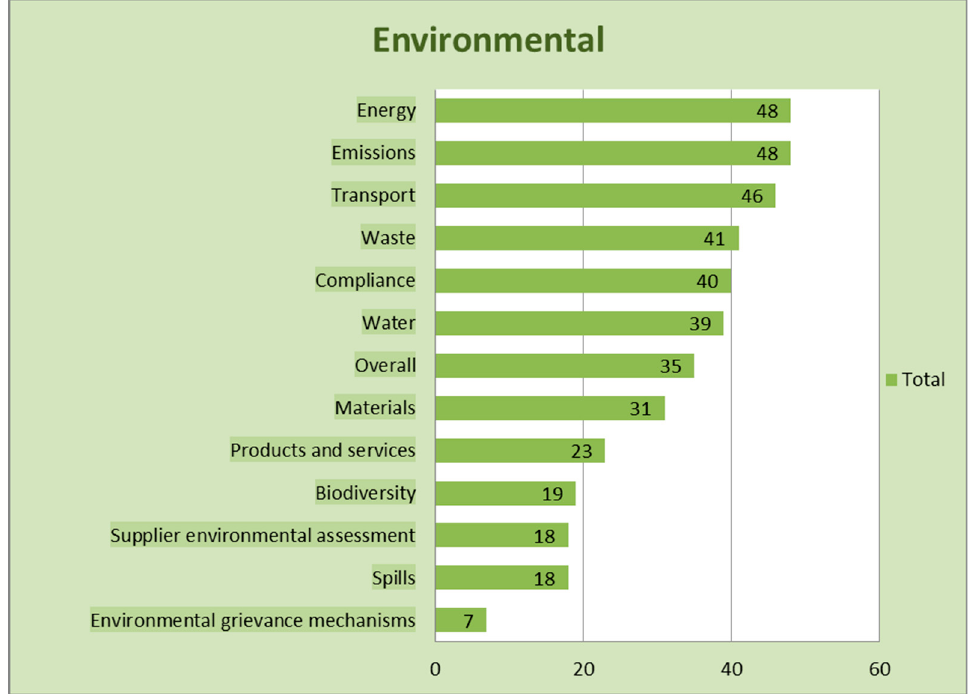
Figure 5. Tallies of occurrence of the environmental sustainability indicators.